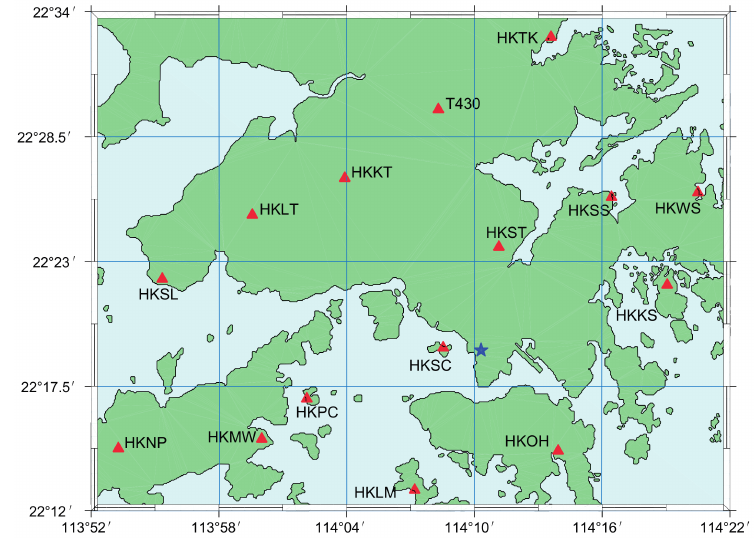
Figure 1. The GNSS (15 red triangles) and radiosonde (1 blue star) stations in Hong Kong. The grid lines are used to determine tomography